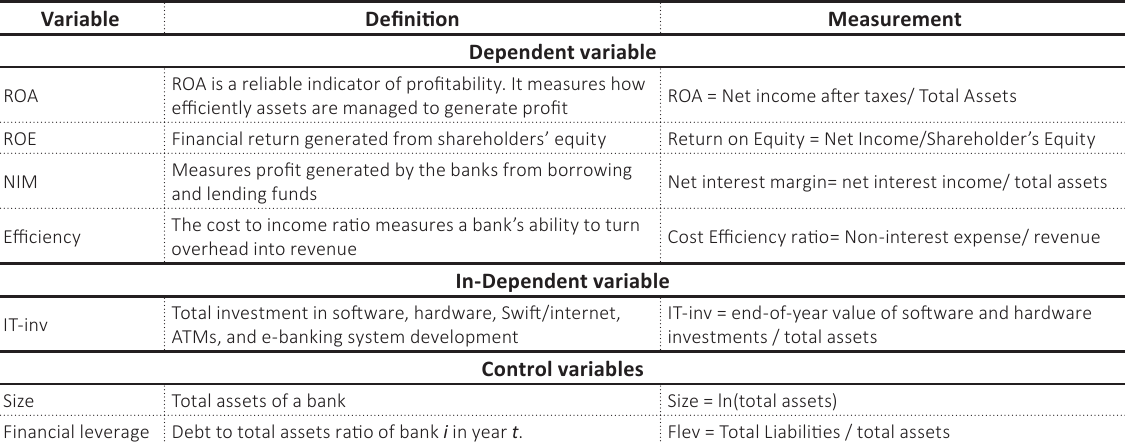
Source: Rose and Hudgins